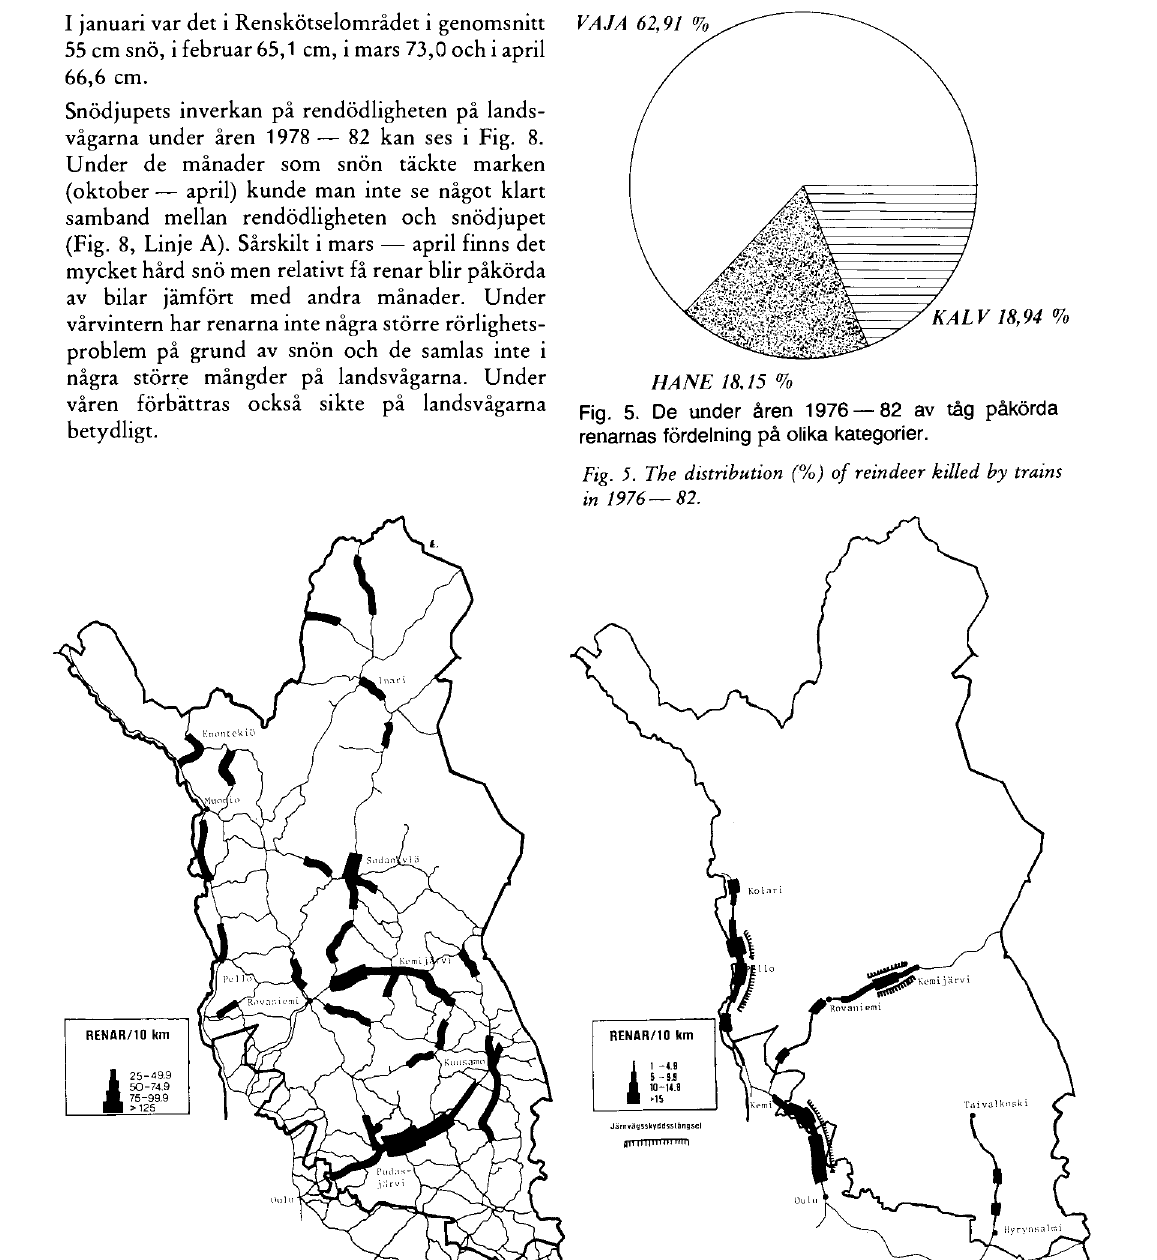
Fig. 6. De under åren 1976 — 82 av tåg påkorda renarnas (renar/10 km) fordelning på de olika banstråckorna. Fig. 6. The number of reindeer killed on different railway sections (reindeer/10 km) in 1976 — 82. RANGIFER, 5 (2),